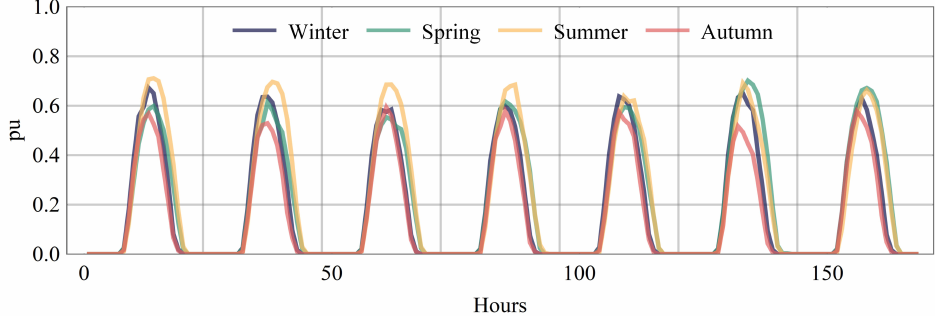
Figure 6. Estimated solar generation for sample weeks of winter, spring, summer, and autumn, in per